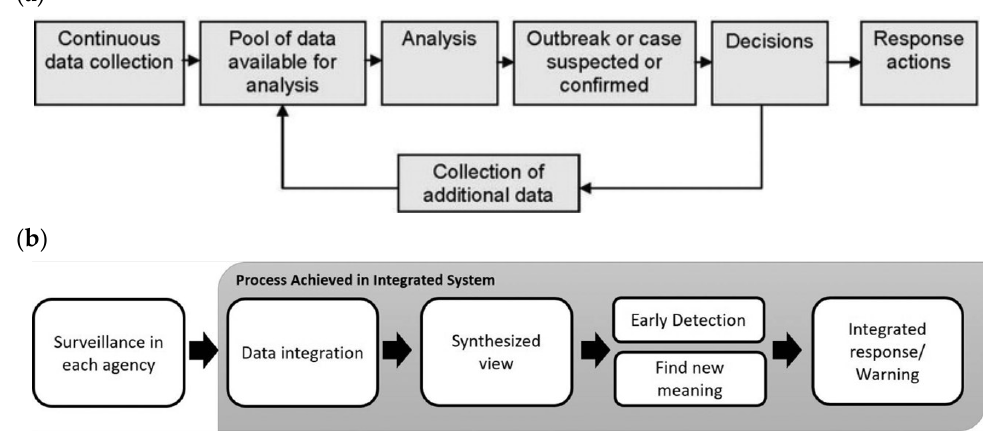
Figure 2. Diagram of biosurveillance process by ( a ) Wagner [7] and ( b ) Kim and Tak [10] .